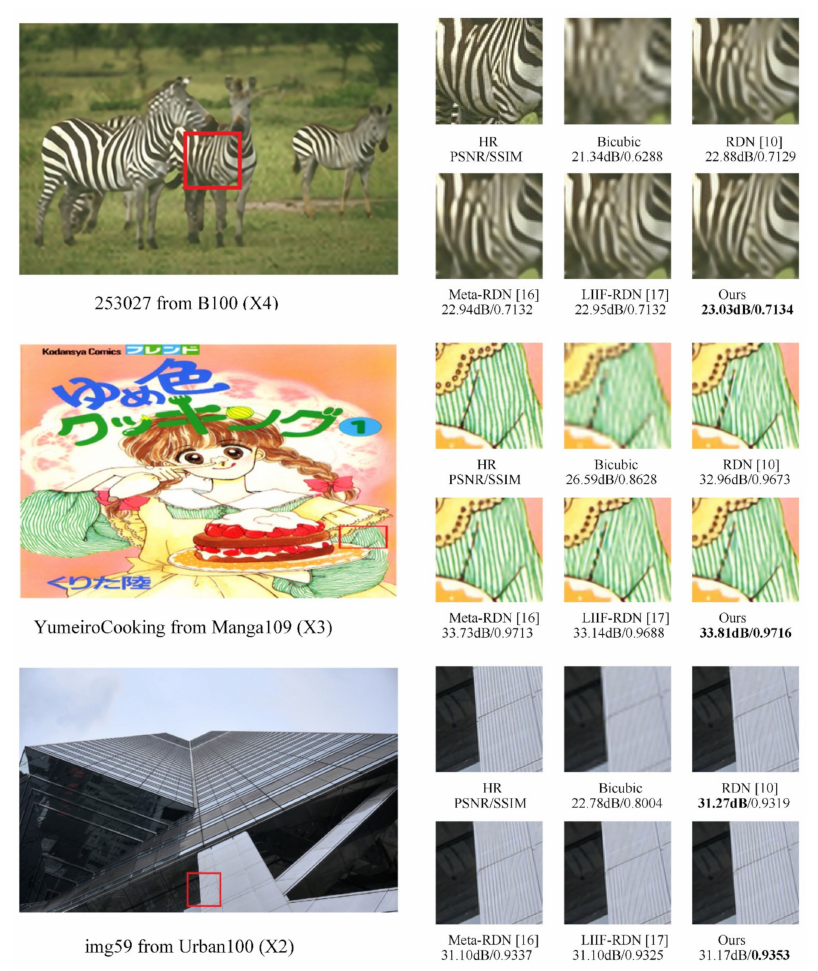
Figure 5. Qualitative performance comparison of various SR